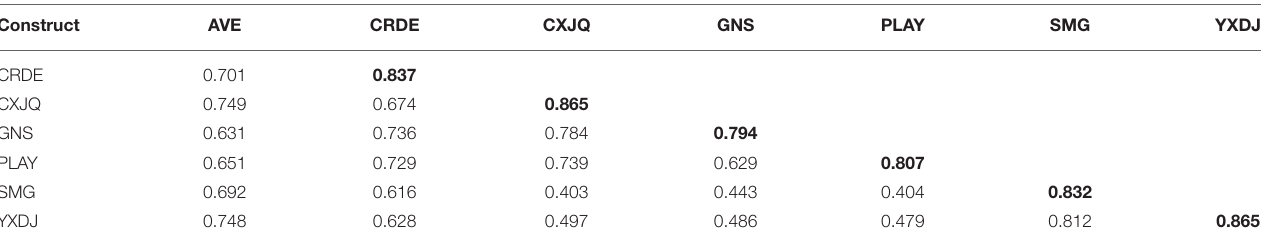
TABLE 7 | Test results of discriminant validity.